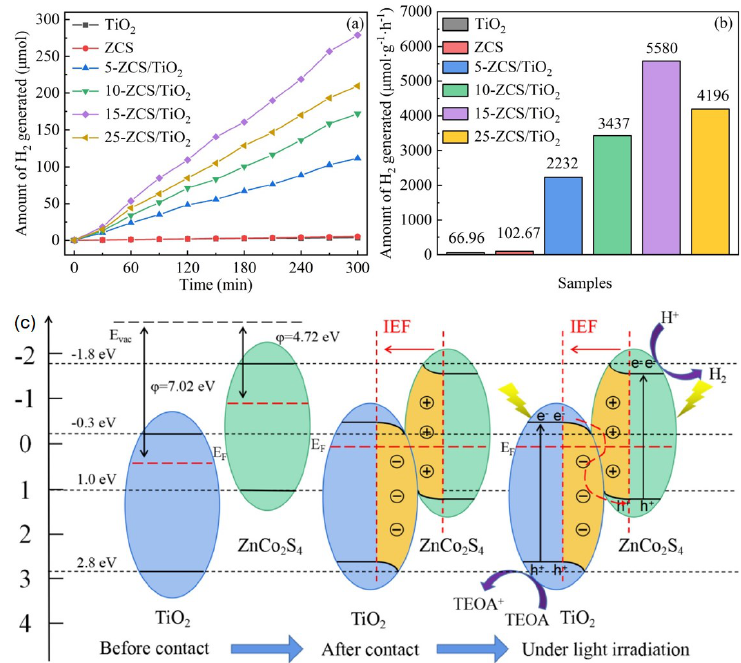
Figure 11. Time evolution ( a ) and average rate ( b ) of photocatalytic hydrogen production activity over the TiO 2 , ZnCo 2 S 4 (ZCS), 5-ZCS/TiO 2 , 10-ZCS/TiO 2 , 15-ZCS/TiO 2 and 25-ZCS/TiO 2 photocatalysts. 5, 10, 15, and 25 are the mass proportion of ZCS in the composite. ( c ) Schematic illustration of the photocatalytic mechanism over the 15-ZCS/TiO 2 photocatalyst: Thus, under Vis-light irradiation, the internal electric field (IEF) induces charge transfer ( a ), separation, and the formation of S-scheme heterojunction ( b ) to realize photocatalytic hydrogen evolution ( c ) [104]. Copyright 2022,